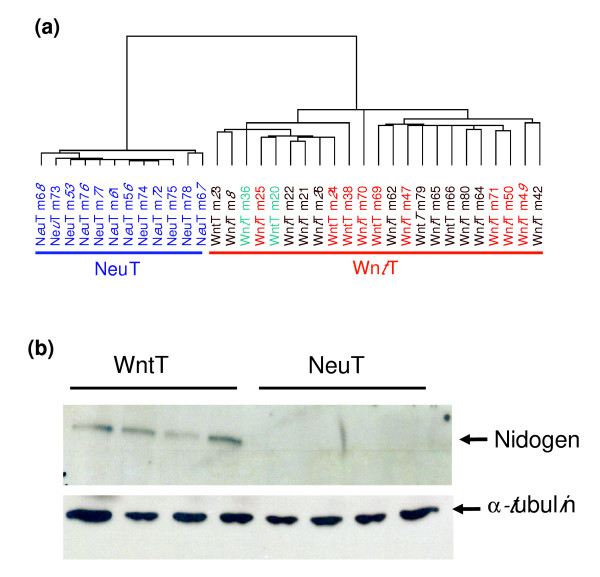
Gene expression in mammary tumors from MMTV-Wnt-1 versus MMTV-Neu transgenic mice. (a) Dendrogram of 35 mammary tumors analyzed by average linkage hierarchical clustering analysis using 1,932 genes selected for high variability across all tumors. 15k arrays were used. The status of Ha-Ras on MMTV-Wnt-1-induced tumors is color coded: red, wild-type; brown, mutant; green, unknown. (b) Western blot analysis for nidogen protein expression on representative mammary tumors from MMTV-Wnt-1 and MMTV-Neu transgenic mice. MMTV, mouse mammary tumor virus; NeuT, mammary tumors from MMTV-Neu transgenic mice; WntT, mammary tumors from MMTV-Wnt-1 transgenic mice.